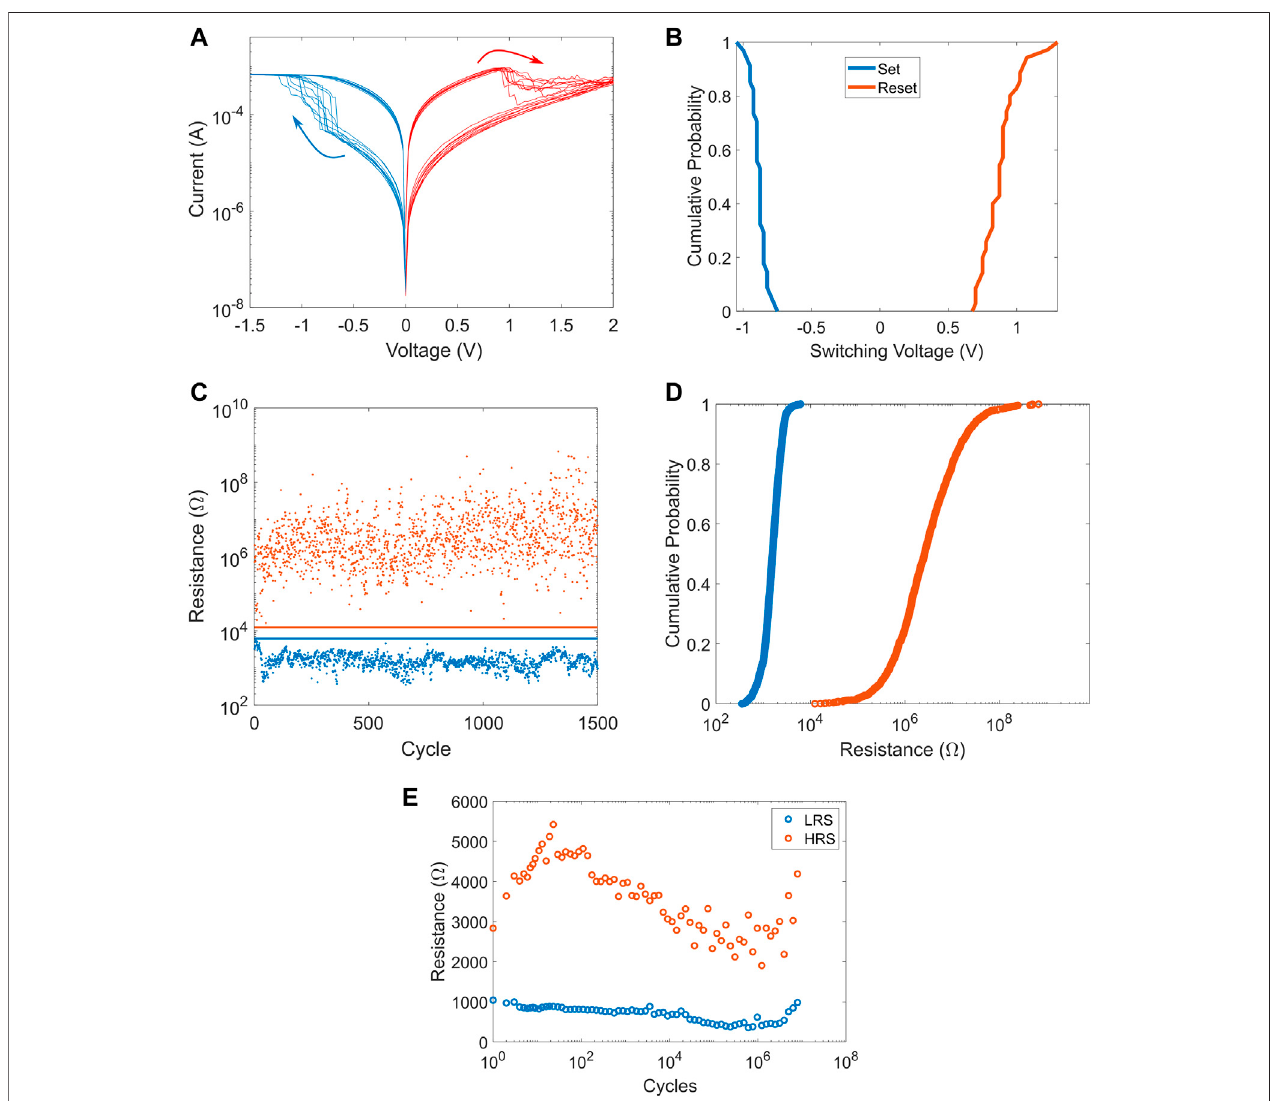
FIGURE 3 | (A) I-V switching curves of an implanted ALD-grown SiO x device. (B) Cumulative probability of switching voltages of an implanted ALD-grown SiO x device. (C) Cycling of the same device from Figure 3a with SMU. The blue line indicates the upper limit of the LRS; the red line is the lower limit of the HRS, there are no data points between the two lines, indicating 100% success rate across 1500 switching cycles. (D) Cumulative probability of the two resistance states. (E) Switching of the same device from Figure 3a using a PMU. Blue dots represent LRS and orange dots represent HRS.